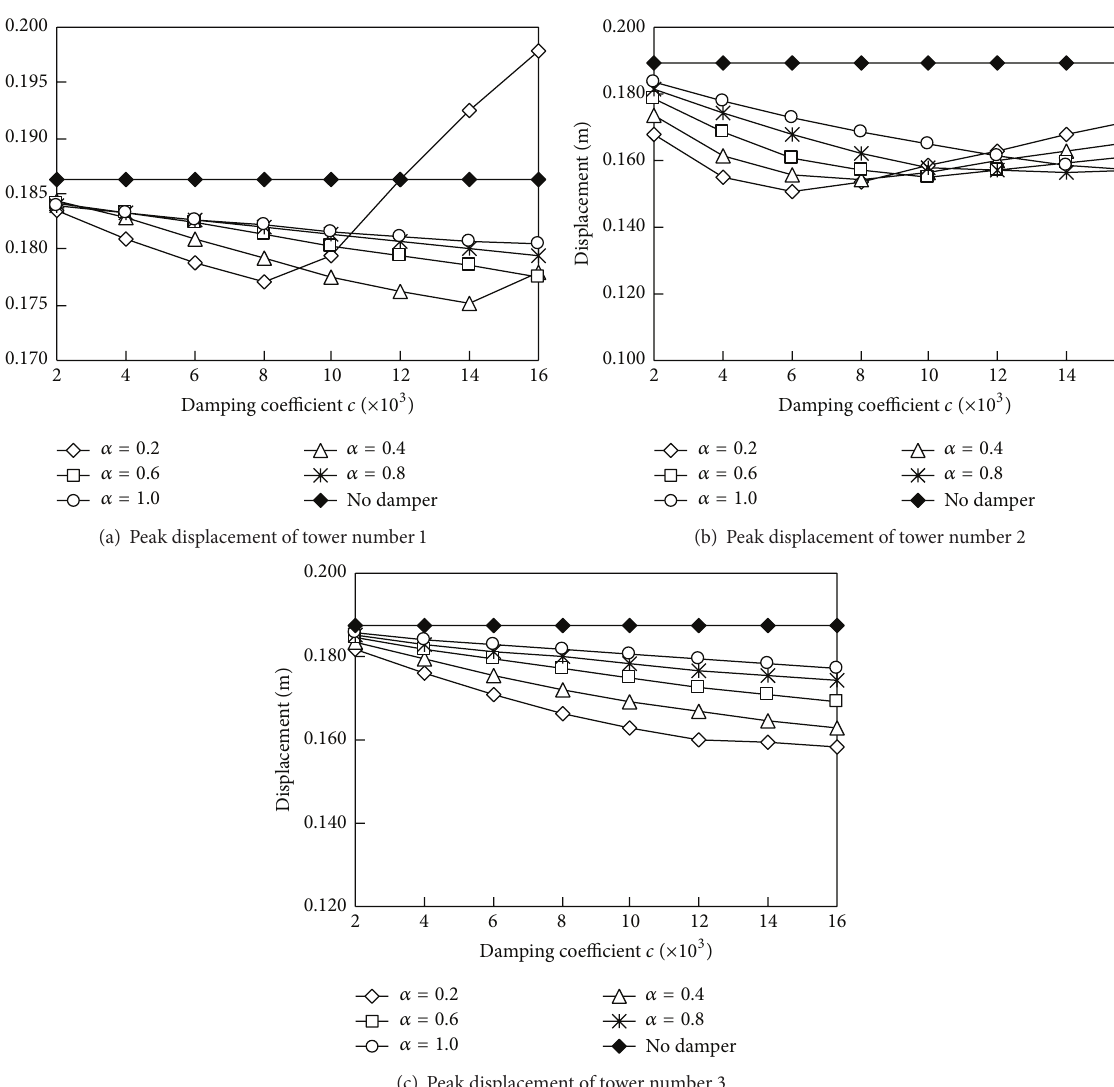
Figure 9: Effects of variations in damping coefficient and velocity exponent of the viscous fluid dampers on the peak displacements on the top of bridge